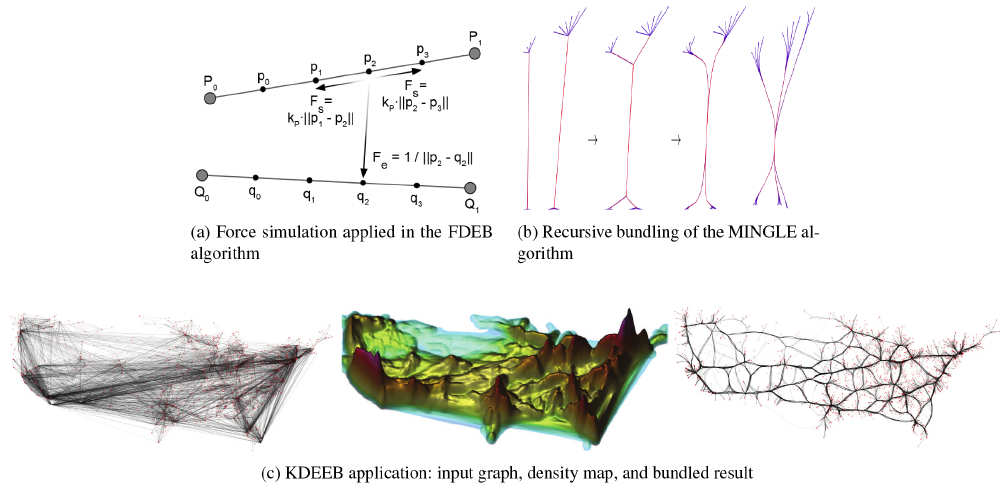
Figure 8. Edge bundling algorithms for geo-referenced networks from the literature. (a) © The Eurographics Association, reprinted from Holten and van Wijk (2009), (b) © 2011 IEEE, reprinted from Gansner et al. (2011) and (c) © The Eurographics Association, reprinted from Hurter et al.